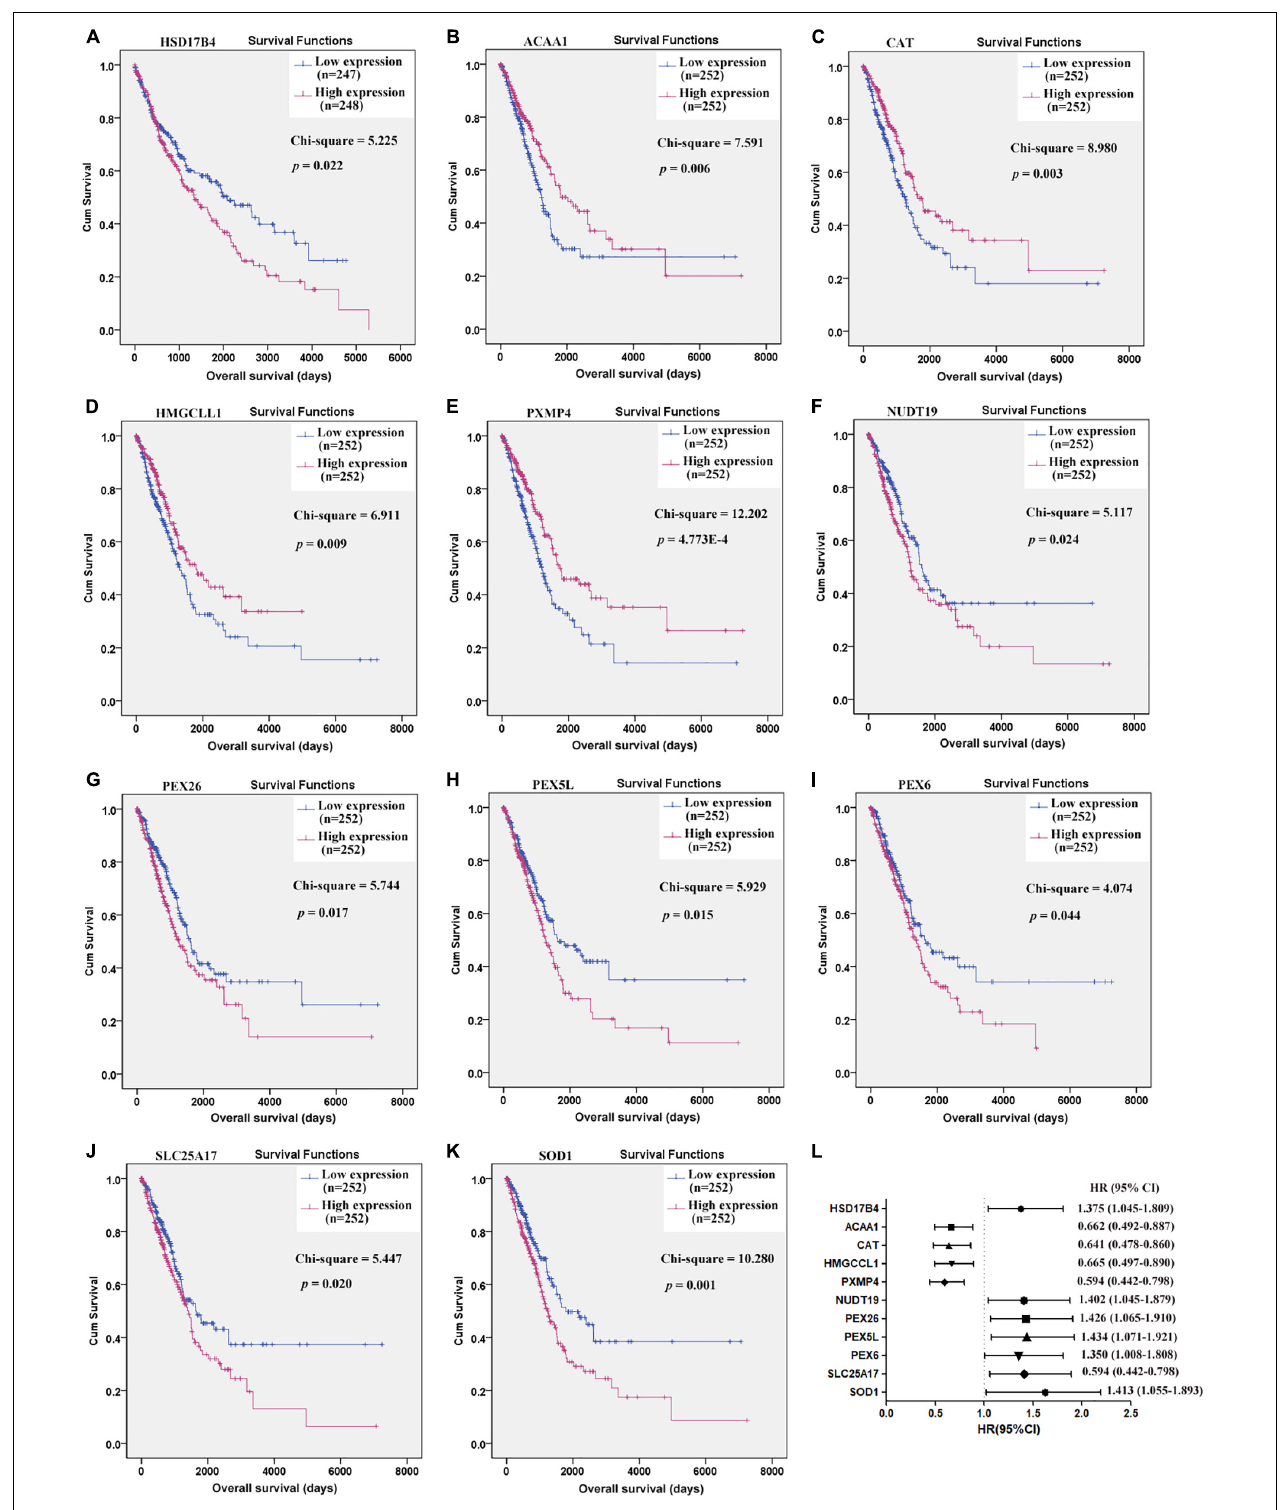
FIGURE 2 | Prognostic effects of the key C-DEPGs (K-DEPGs) on NSCLC overall survival (OS). (A) Higher expression of HSD17B4 indicated shorter OS in LUSC patients. (B–E) Higher expression of ACAA1, CAT, HMGCLL1, and PXMP4 indicated longer OS in LUAD patients. (F–K) Higher expression of NUDT19, PEX26, PEX5L, PEX6, SLC25A17, and SOD1 indicated shorter OS in LUAD patients. (L) The HRs of the high expression groups of the genes, in contrast to the low expression group. NSCLC, non-small cell lung cancer; LUSC, lung squamous carcinoma; LUAD, lung adenocarcinoma; C-DEPGs, common differentially expressed peroxisome pathway genes in NSCLC. Kaplan–Meier survival (A–K) and Cox regression analyses (L) were used and p < 0.05 was considered to be significant.